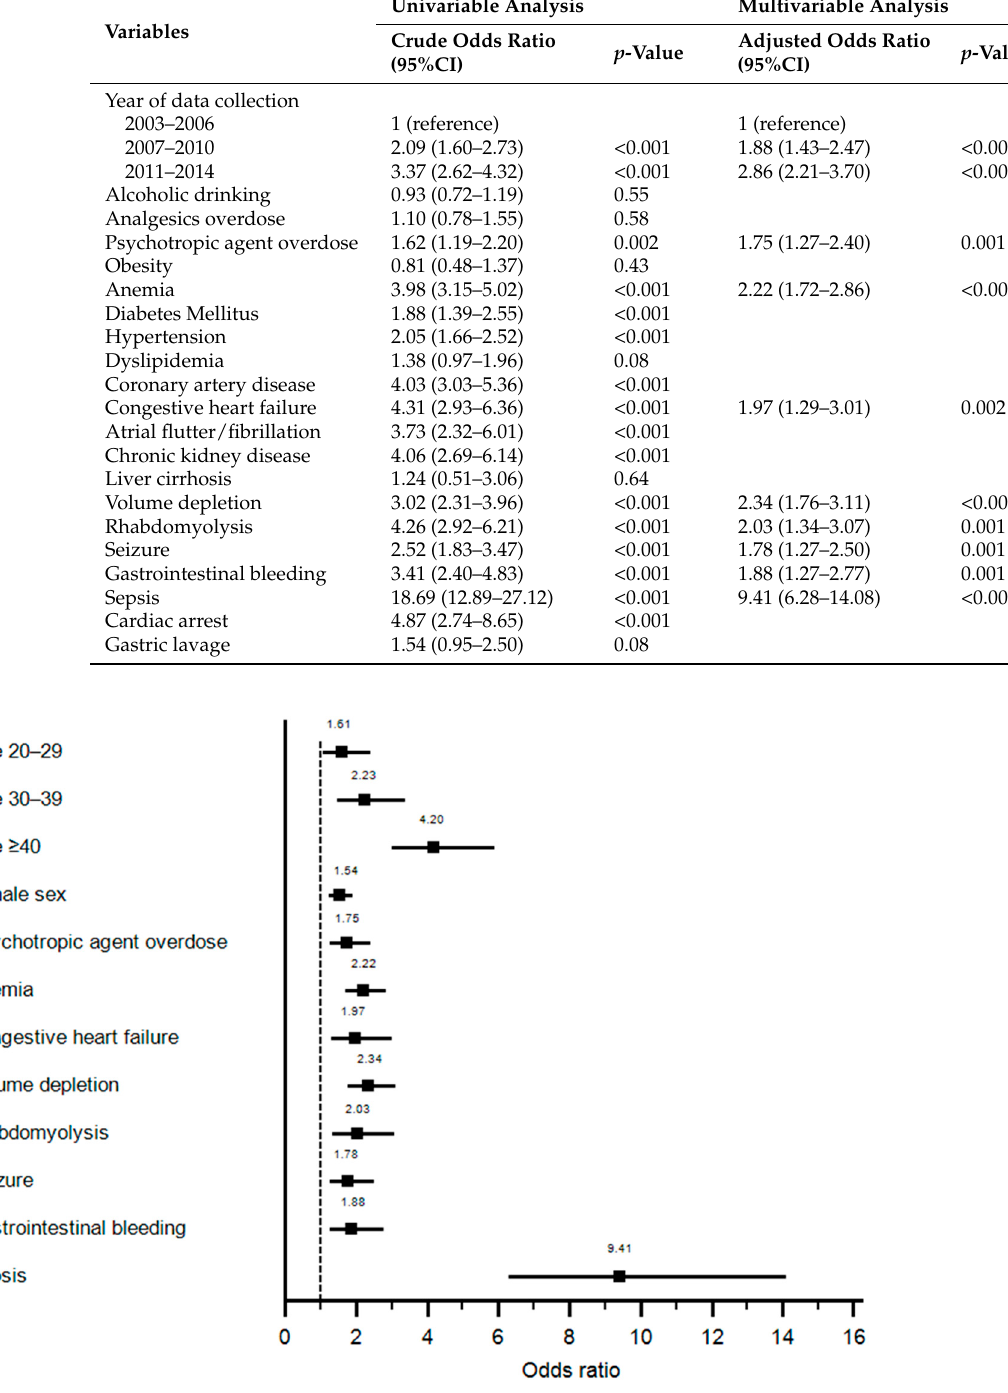
After adjusting for differences in baseline clinical characteristics, salicylate intoxication patients with circulatory shock required more invasive mechanical ventilation (OR 5.01; p < 0.001), blood transfusion (OR 3.12; p < 0.001), and dialysis (OR 3.04; p < 0.001). Circula- tory shock in salicylate intoxication patients was significantly associated with